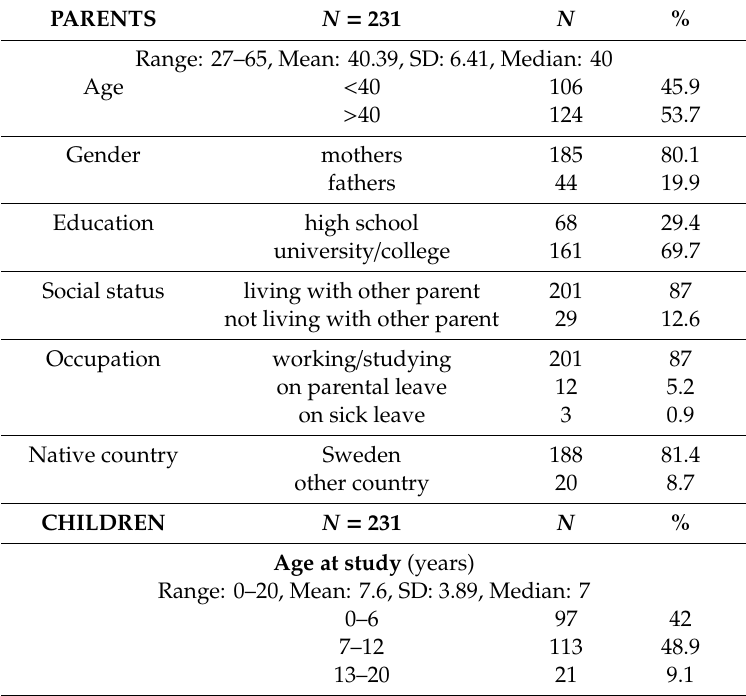
Table 1. Demographics of parents and